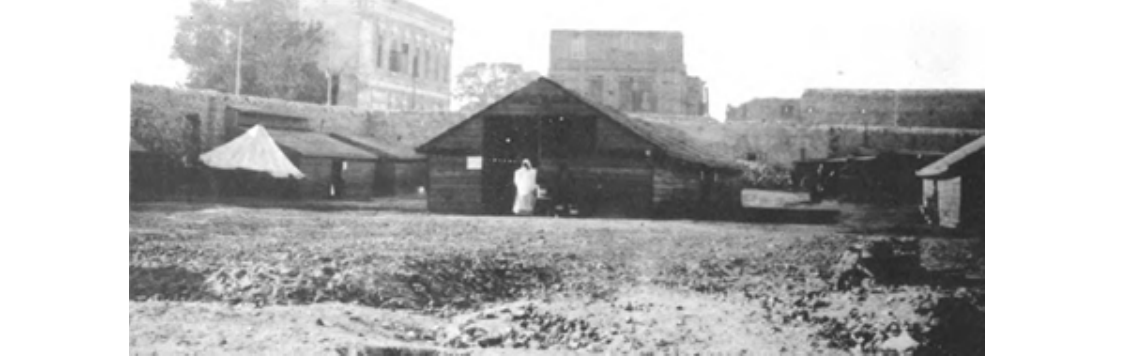
Figure 6. Temporary cholera huts at Old Cairo (Source: Egypt, Ministry of the Interior, Sanitary Department, Report on the Epidemic of Cholera in Egypt during the Years 1895 & 1896 (Cairo: National Printing Office, 1897), 60. Courtesy: University of Chicago